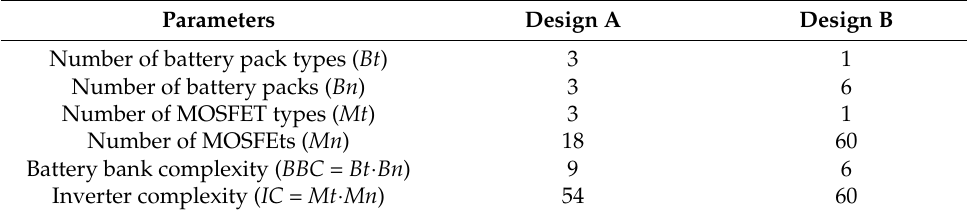
Table 4. Complexity